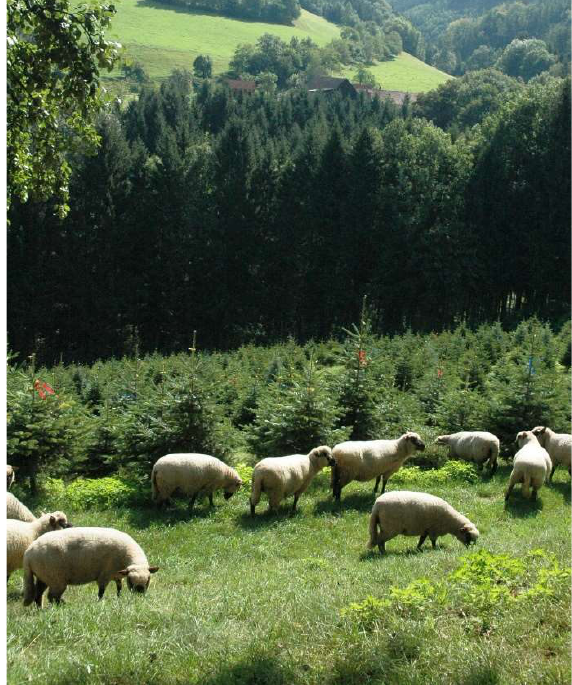
Figure 2. Shropshire (or Shrops) sheep grazing in Christmas tree plantation. They prefer grazing on grasses and other weeds than on Christmas trees and thereby help in controlling